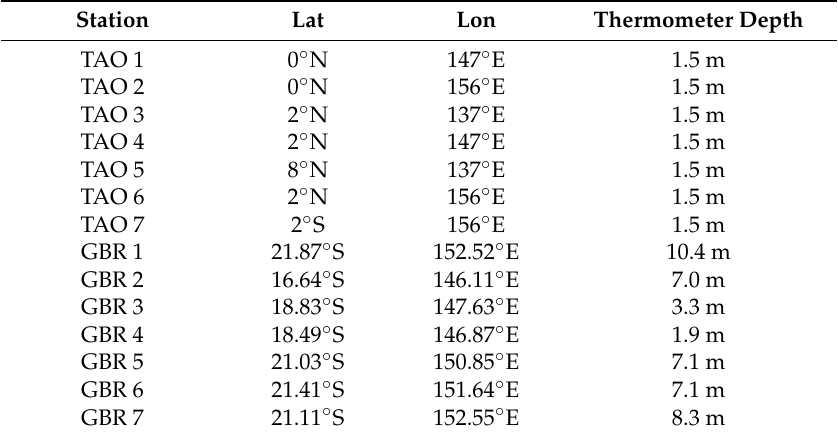
Table 2. Locations and depth of in situ